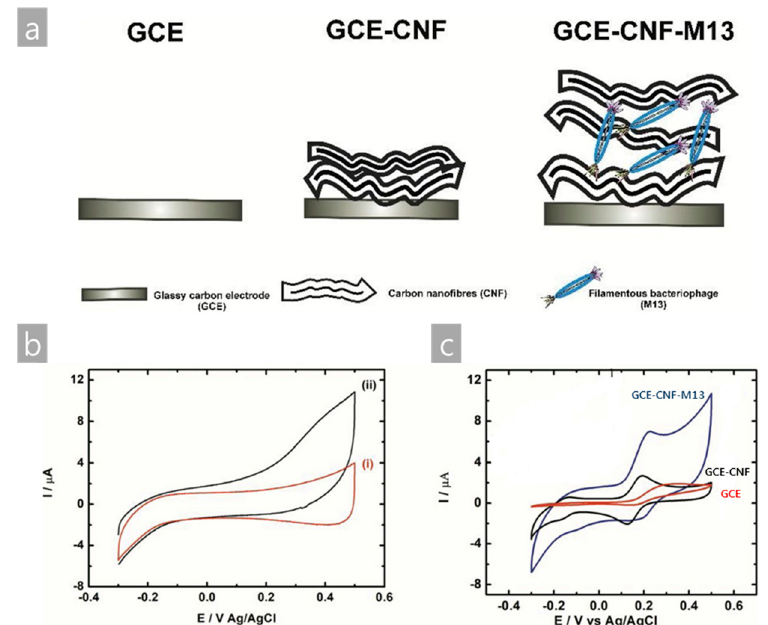
Figure 3. ( a ) Schematic diagram of the device fabrication of the CNF and M13 bacteriophage complex electrode, ( b ) cyclic voltammograms (3rd scan) of (i) glassy carbon electrode (GCE)–CNF and (ii)